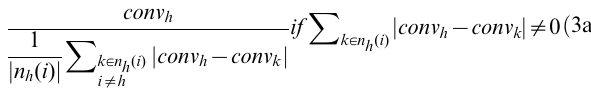
Figure S2, Interaction network of 81 motif topologies that linked the linear, feedback, feed-forward, bifan, and isolated feedback motifs. Table S1, Reaction networks describing the dynamics of the signaling motif. Table S2, Ordinary differential equation (ODE) modeling describing the dynamics of the signaling motif. Table S3, Motif topologies that connected the linear, feedback, feed-forward, bifan, and isolated